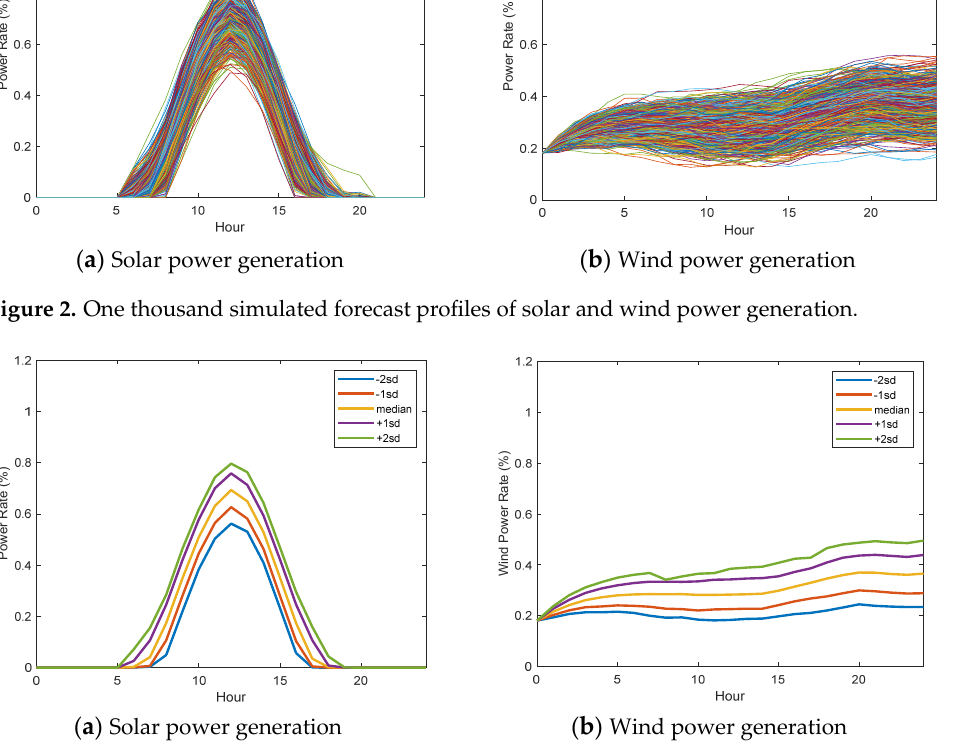
Figure 3. 5 Representative forecast profiles of solar and wind generation.